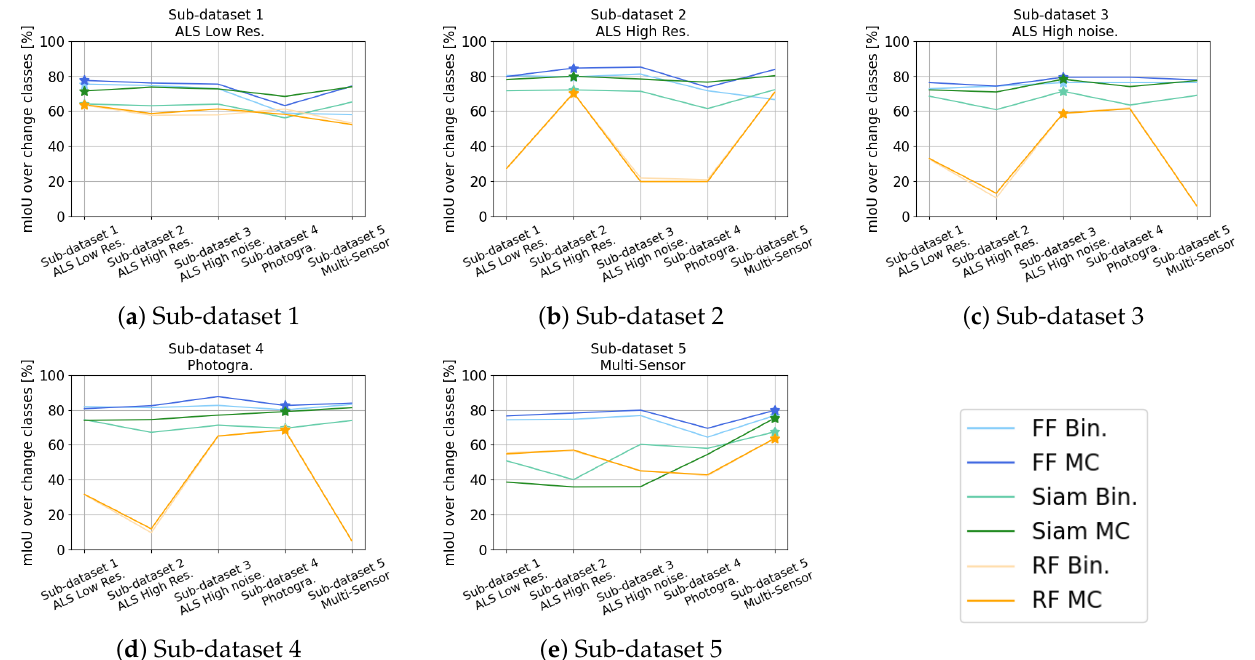
Figure 14. Results of different tests of transfer learning. Each sub-figure presents results when training on the training set of a specific sub-dataset and testing on other sub-datasets. Results marked with stars correspond to reference tests without transfer. Means of IoU over classes of change are given (%). Bin. stands for binary classification results, MC for multi-class classification results, Res. for